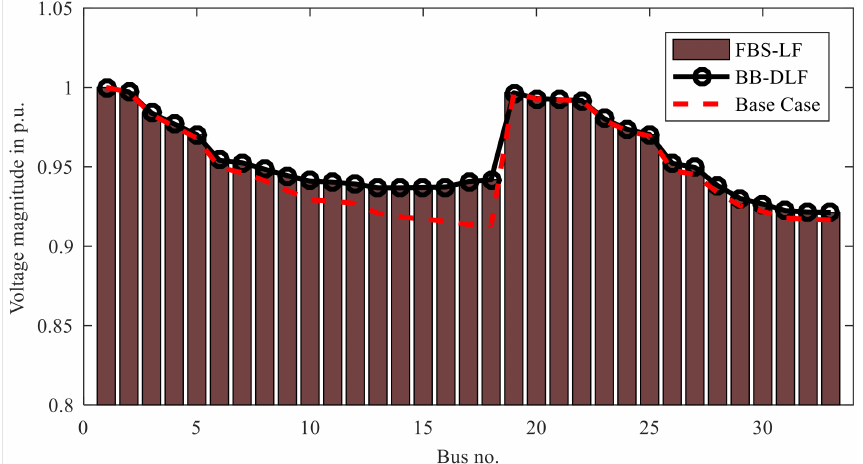
Figure 7. Comparison of voltage profile of PDN as obtained by FBS-LF and BB-DLF when a 500 kVAr D-STATCOM is allocated to bus 18 of 33-bus